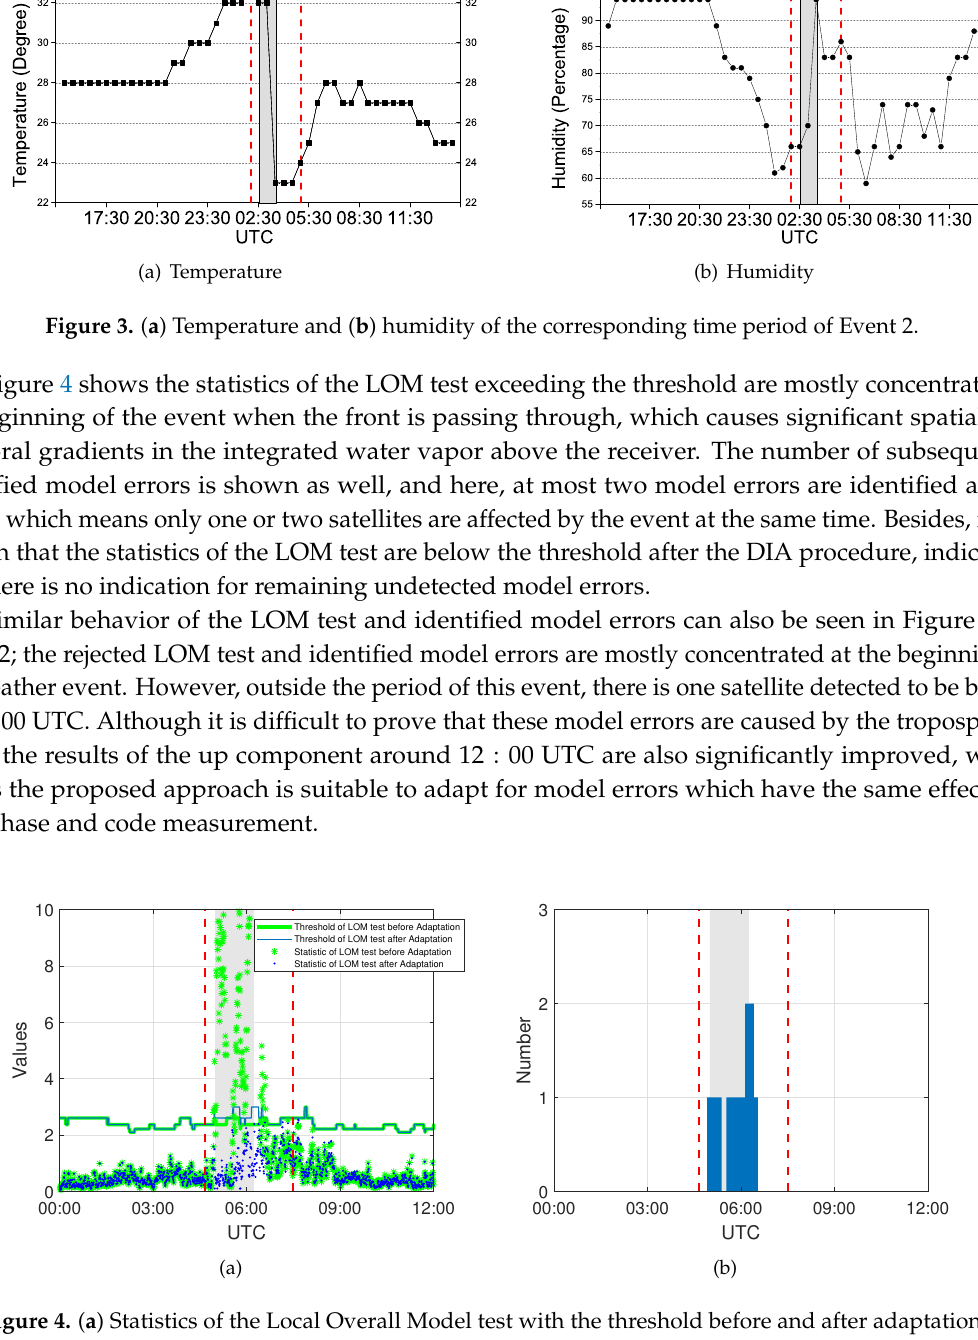
Figure 4. ( a ) Statistics of the Local Overall Model test with the threshold before and after adaptation and ( b ) the model errors identified at each epoch during Event